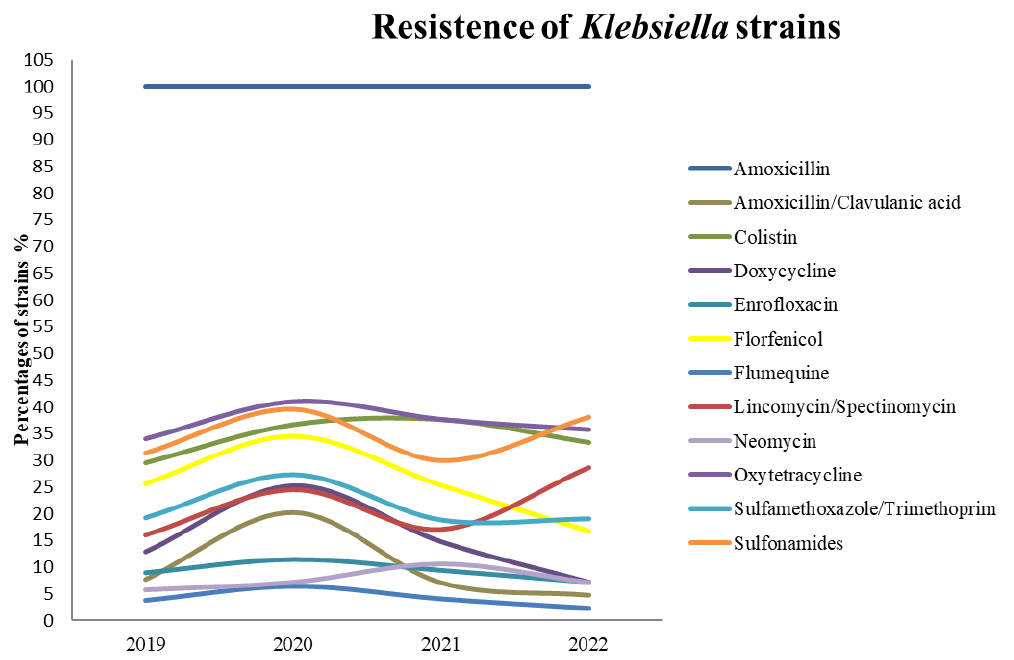
Figure 1. Percentage of antibiotic resistant Klebsiella strains in the consecutive years between 2019 – 2022.